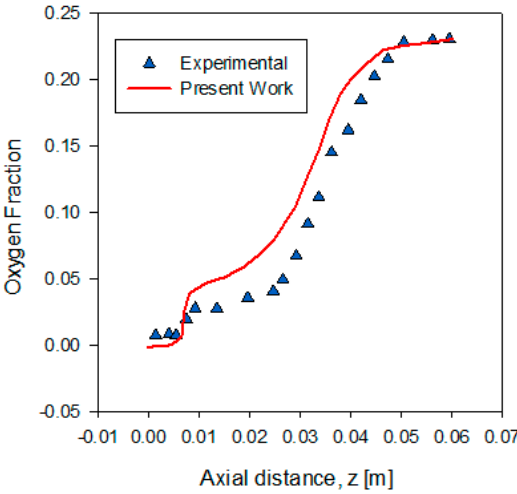
Figure 6. Oxygen concentration along the centerline of the primary burner of the incinerator compared with Reference [34].